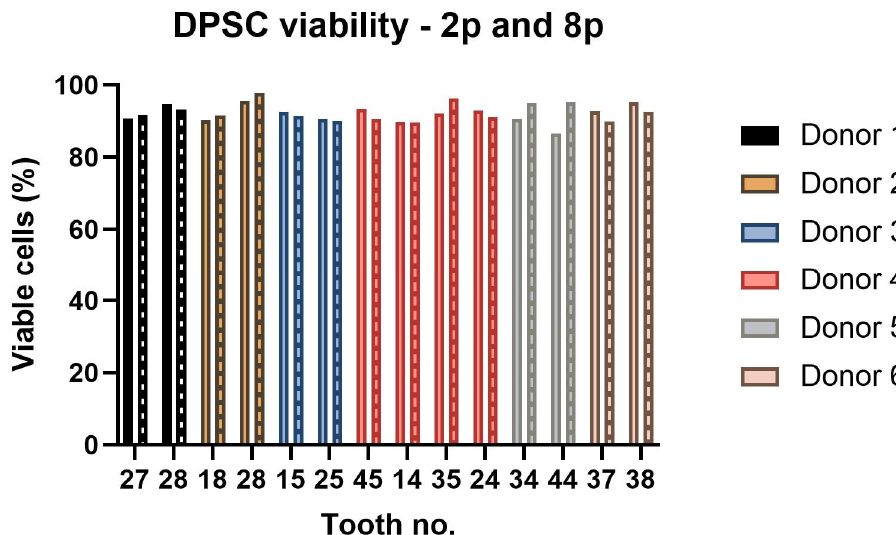
Figure 4. The DPSC viability of all paired lineages evaluated in the 2nd (2p) and 8th (8p) passages (boxes filled with pattern). The graph presents the percentage of viable cells. The statistical analysis was performed using a paired t -test; no comparison was statistically significant.